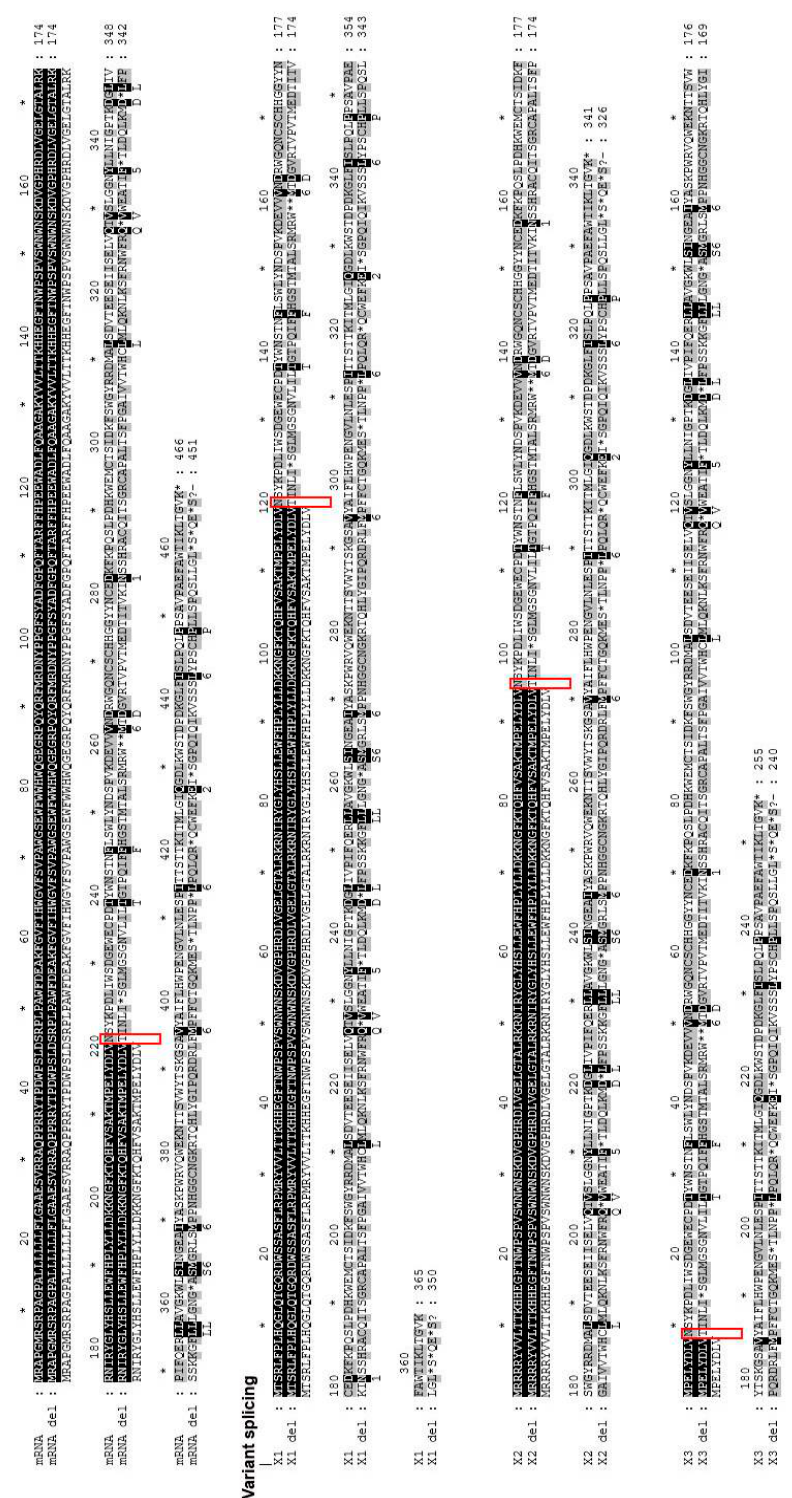
Figure 2. The effect of the 9-base-pair deletion (NG_013346.1:g.10233_10241delACAGGTAAG). The cDNA sequence trace of the child with fucosidosis was translated into amino acids using the blastx option and aligned with both canonical FUCA1 (NM_000147) mRNA and each of the predicted transcript variants (X1: XM_017000905, X2: XM_005245821 and X3: XM_011541167) translated into corresponding amino acids. Sequence similarity is depicted by different colors, with black indicating the complete similarity of sequences.